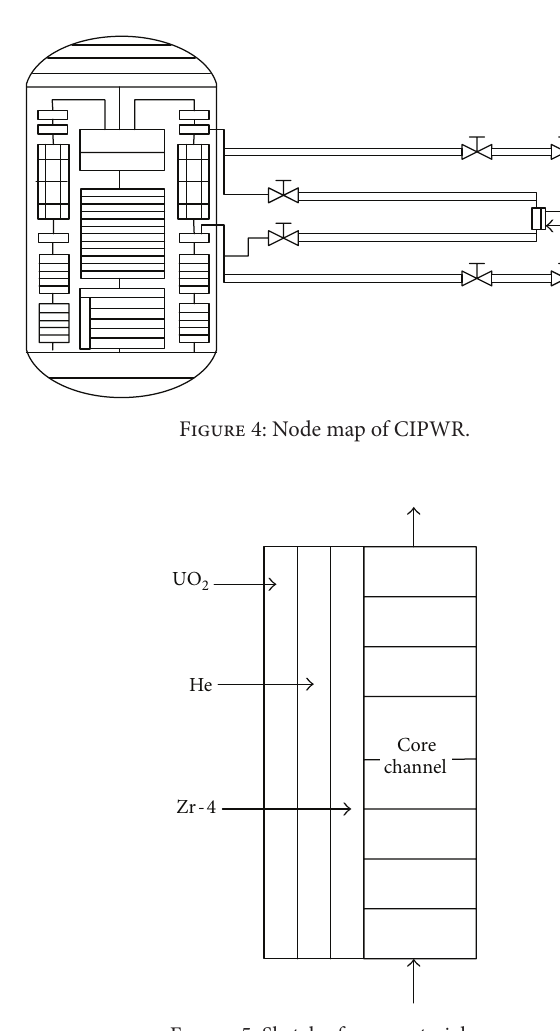
Figure 5: Sketch of core